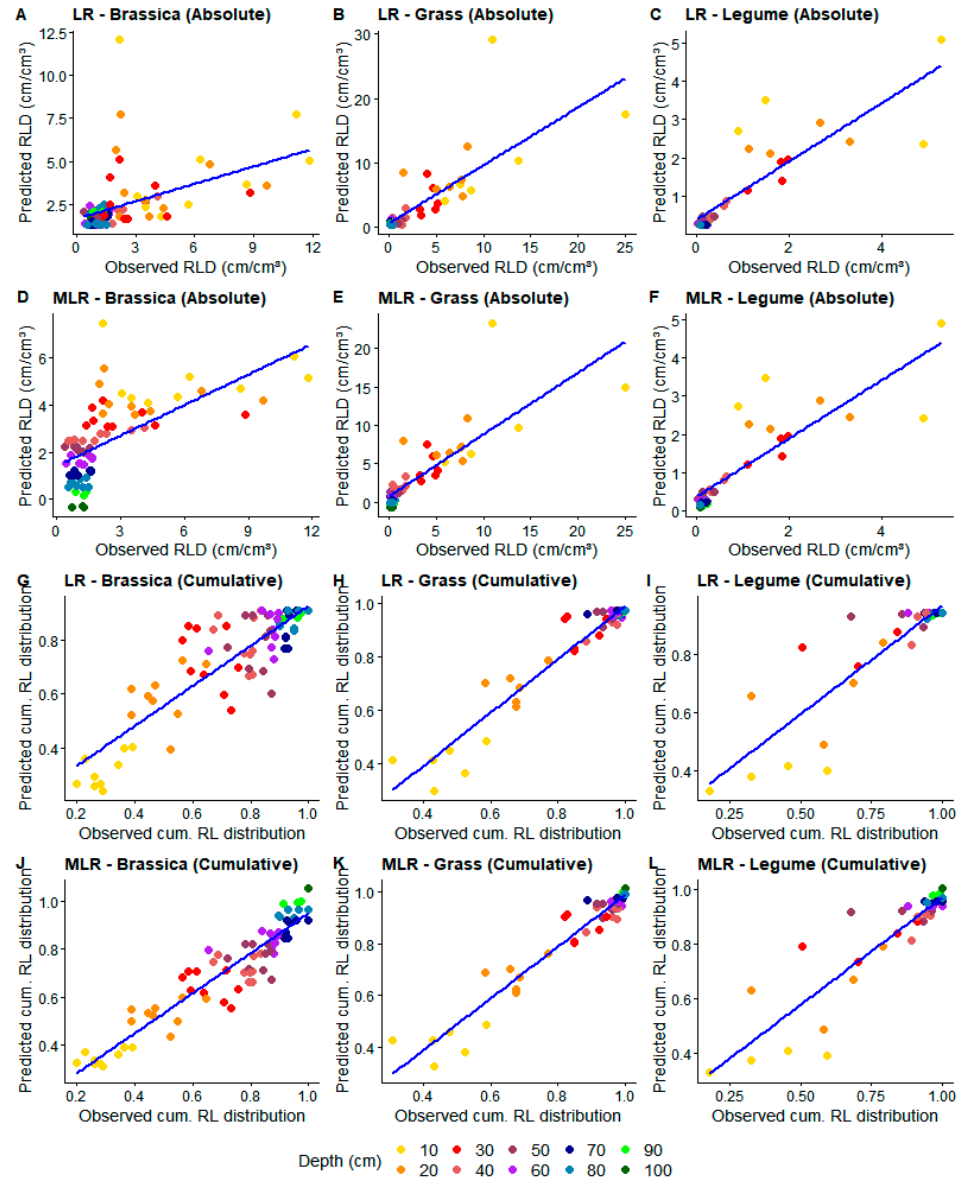
Figure 3. Relationships between observed and predicted root ‐ length density (RLD) using linear (LR) ( A – C , G – I ) and multiple linear regression (MLR) ( D – F , J – L ) for absolute ( A – F ) and cumulative (cum. RL) ( G – L ) data. Colors show soil depth (cm) of each value.